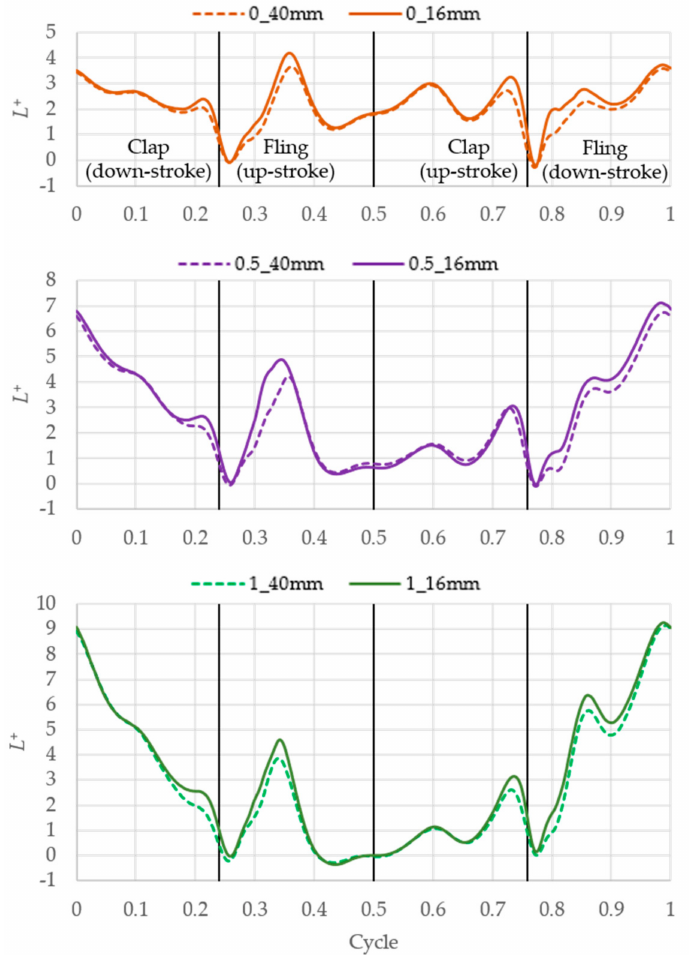
Figure 12. Time courses of lift generated by the wing pair for various inflow